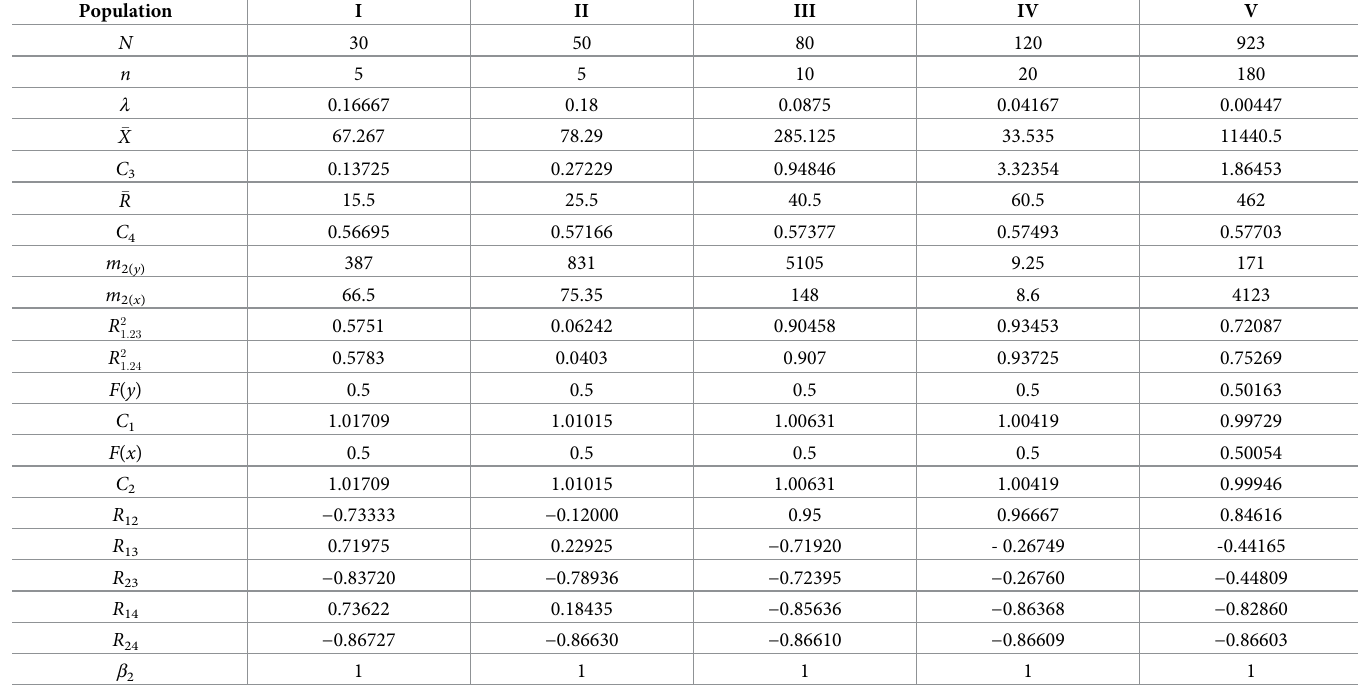
Table 2. Summary statistics for Populations I to V.